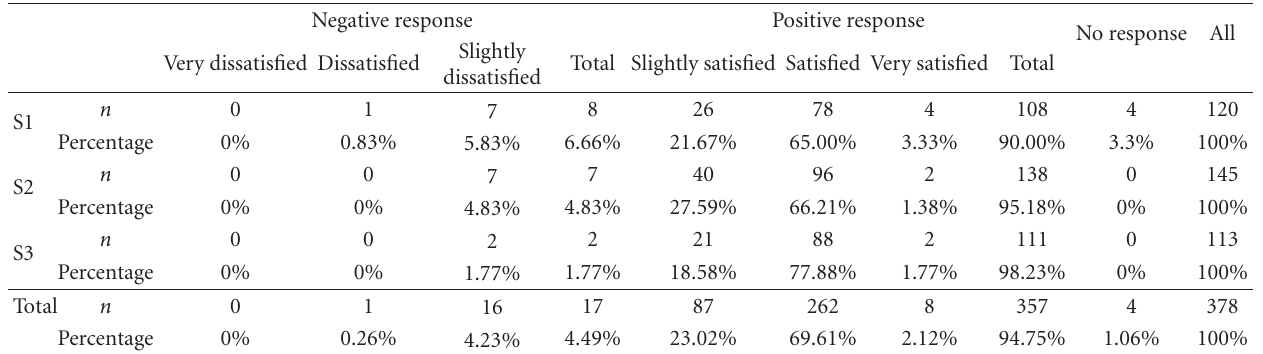
Table 6: Perceived degree of workers’ overall satisfaction of the